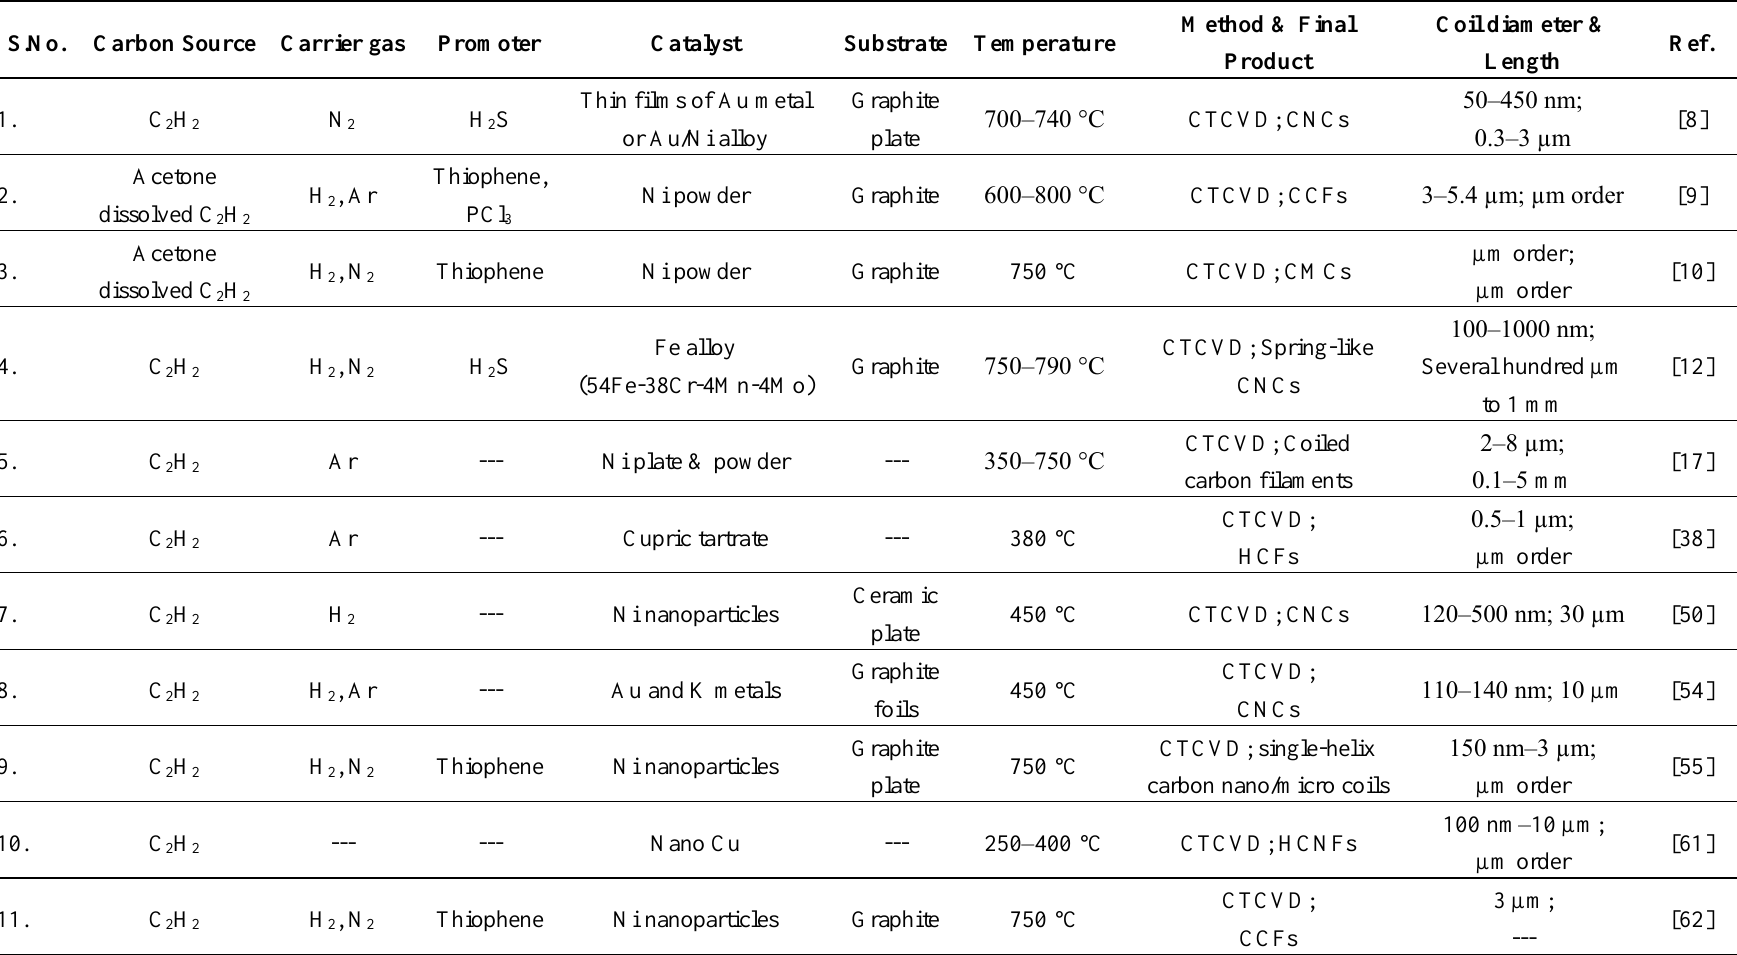
Table 1. Growth conditions for the synthesis of helical carbon fibers